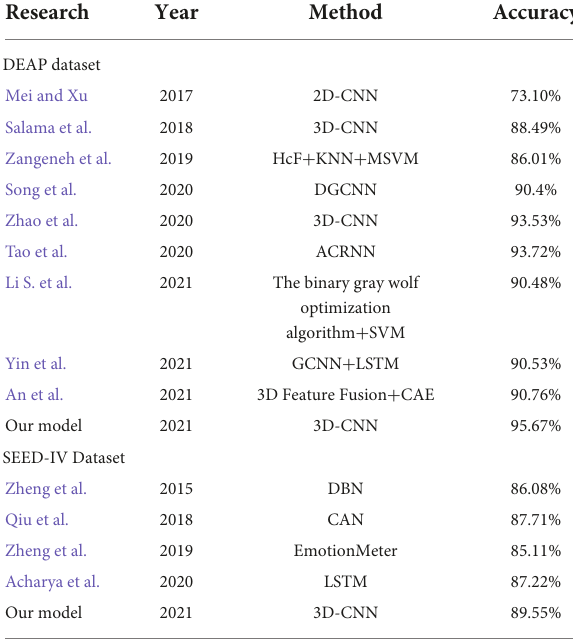
TABLE 4 Comparison of ERN model with previous